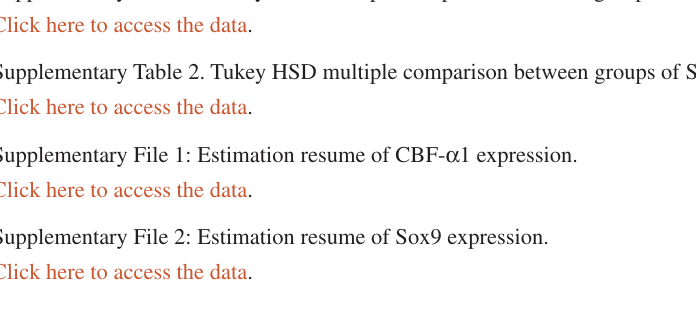
Supplementary Table 1. Tukey HSD multiple comparison between groups of CBF- α 1. Click here to access the data. Supplementary Table 2. Tukey HSD multiple comparison between groups of Sox9 expression. Click here to access the